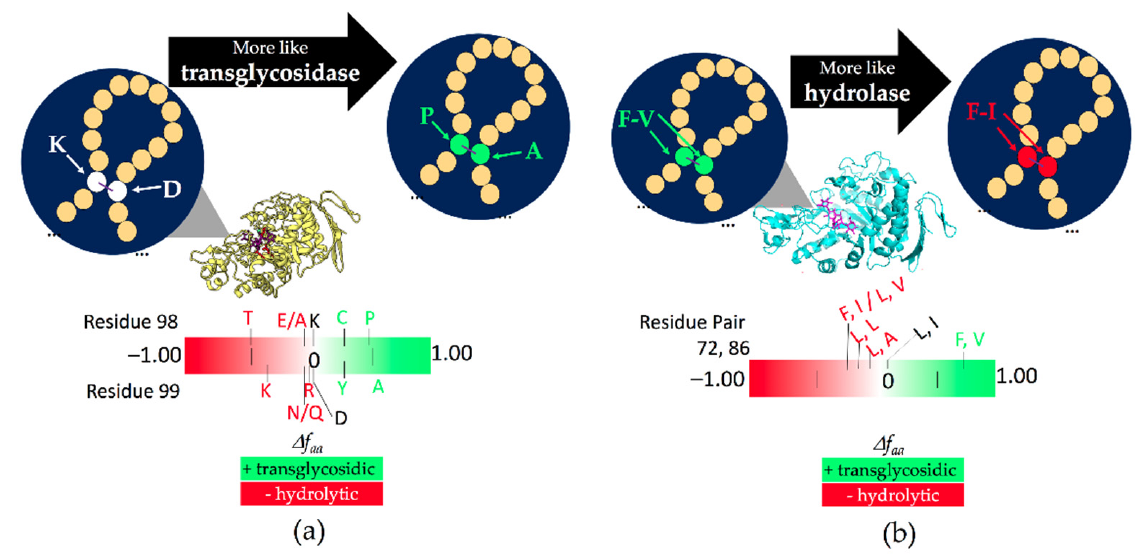
Figure 4. Schematic representation of substitutions in glycosidases based on enrichment factors. ( a ) K98P/D99A in TmAmyA ( b ) F72L/V86I for TmGTase. The residues more frequently found in hydrolases and transglycosylases are shown in the lower part of the figure for each pair in red and green, respectively.